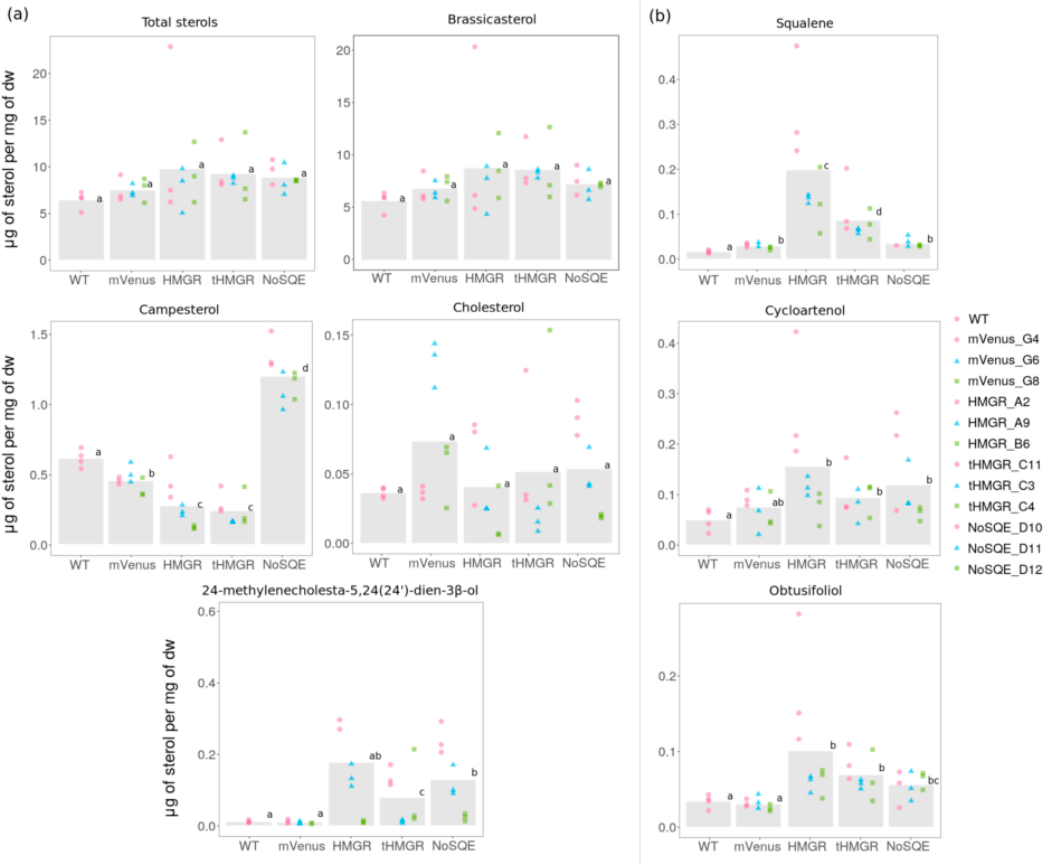
Figure 4. Sterol levels in P. tricornutum transformants. ( a ) End-point sterol ( b ) intermediates accumulation. Identical letters denote no statistically significant di ff erences among groups using the Pairwise Wilcoxon Rank Sum tests ( p < 0.05, n =